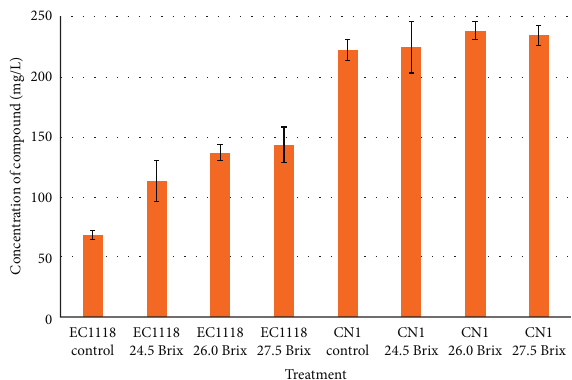
Figure 3: 2-Phenylethanol concentrations for control (no dehy- dration) and treatment wines made from partially dehydrated grapes fermented with S. cerevisiae EC1118 or S. uvarum CN1. Values are averages of 8 data points (duplicate measurements of 2 winemaking replicates, 2 bottles per replicate) ± standard deviation.